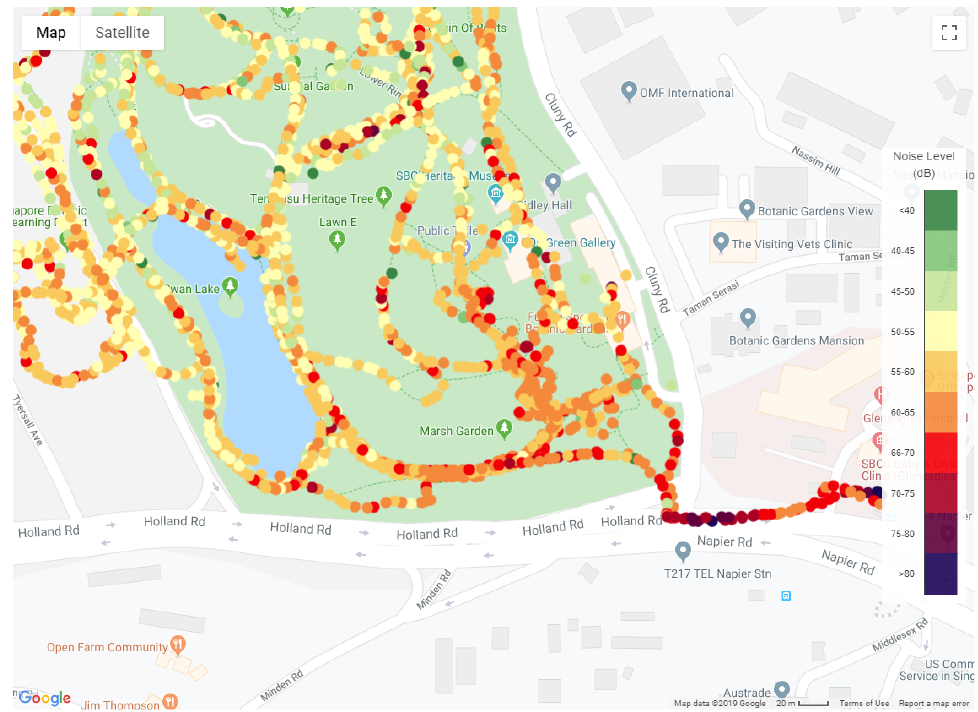
Figure 5: The noise map of the bottom right hand corner of the Singapore Botanic Gardens near the Tanglin Gate (enlarged view of the middle portion of Figure